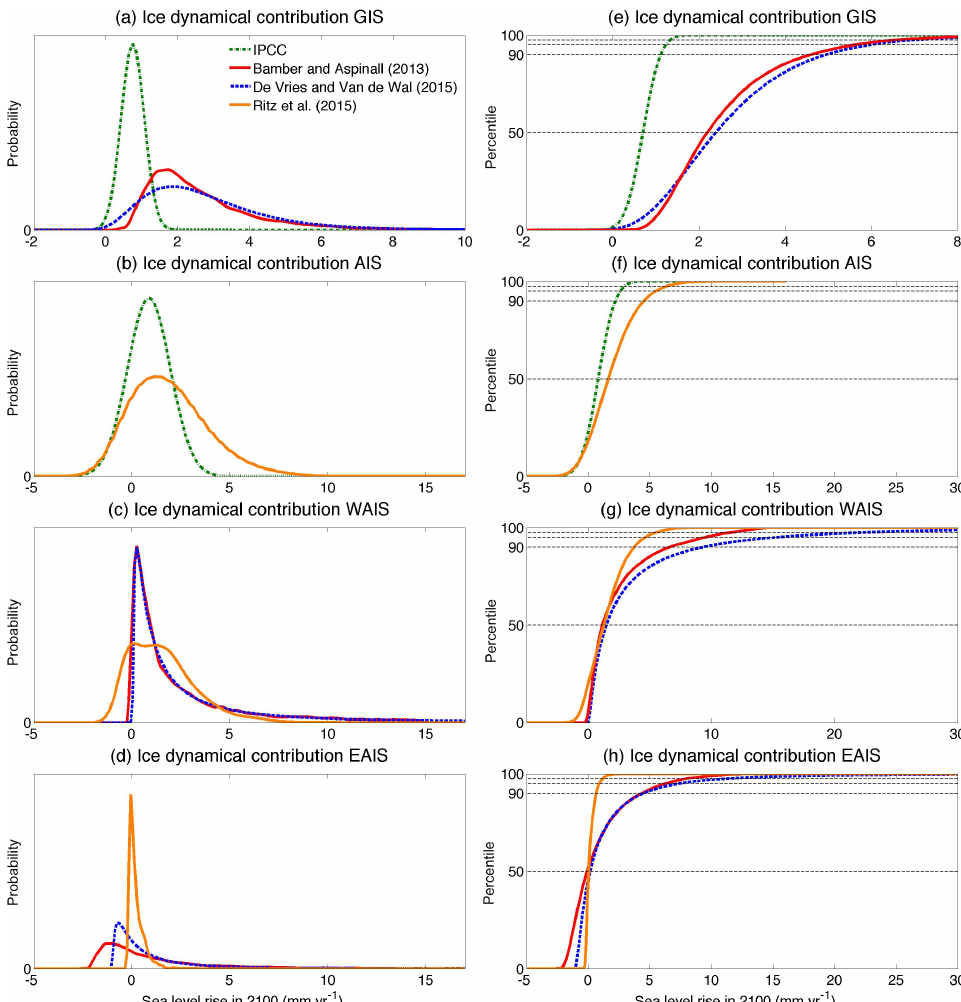
Figure 1. Probability density functions (left column) and cumulative density functions (CDFs) (right column) for dynamical ice sheet mass loss of Greenland ice sheet (GIS), Antarctic ice sheet (AIS), West Antarctic ice sheet (WAIS) and East Antarctic ice sheet (EAIS). IPCC-AR5 does not have separate distributions for WAIS and EAIS. In the CDFs the dotted lines indicate the 90th, 95th and 97.5th